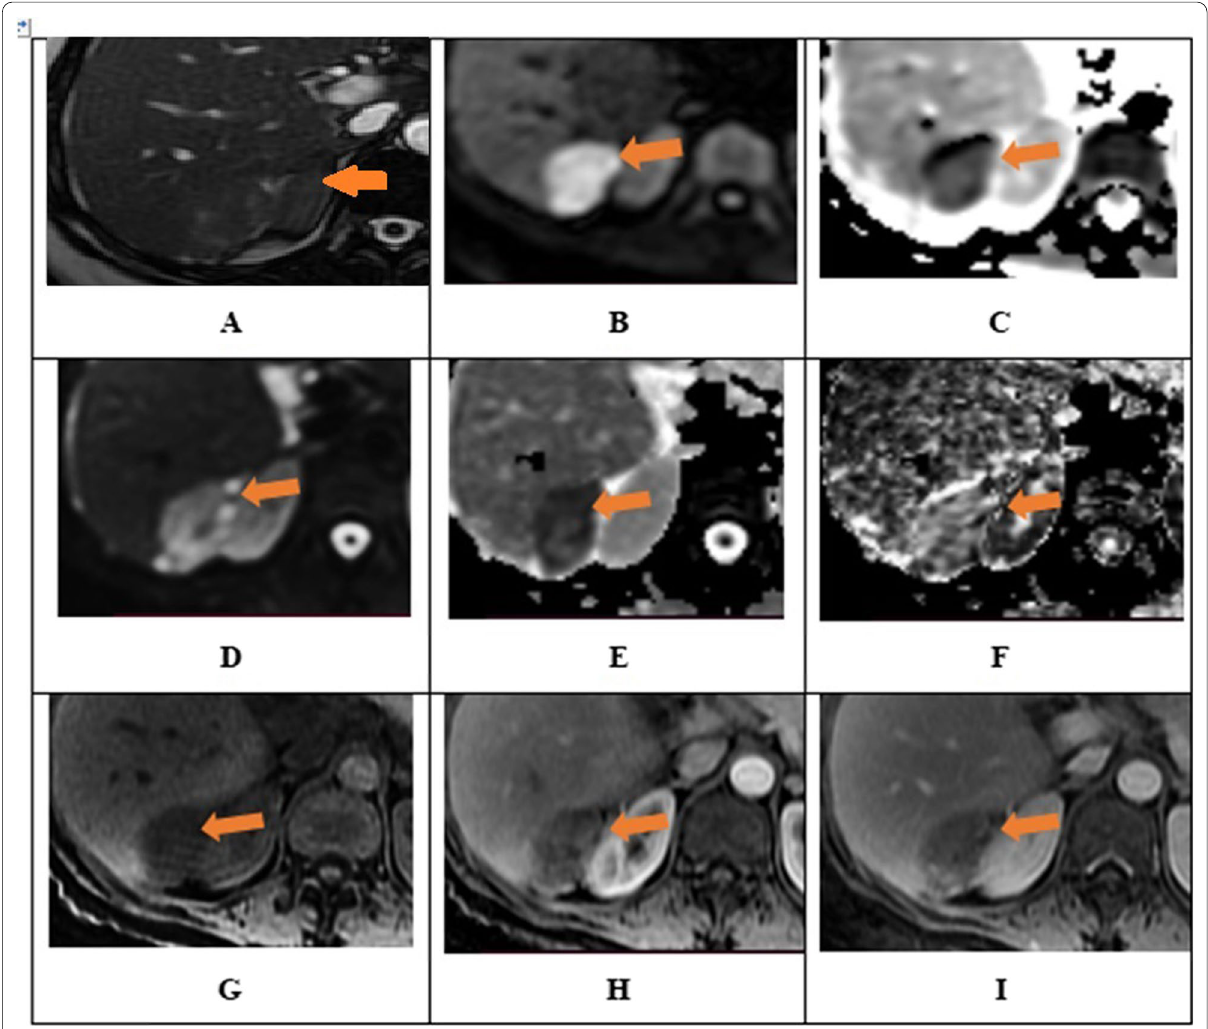
Fig. 2 A 45-year-old female patient with positive HCV and history of ovarian cancer underwent abdominal ultrasonography that showed right hepatic focal lesion. A Axial T2 image shows a 4 cm segment VI focal lesion displaying low T2 signal. B axial diffusion and C ADC images show marked diffusion restriction with DWI-ADC value 0.82 D Axial DTI gray scale image, E DTI-ADC map and F FA map: the DTI-ADC value is 0.57 and the FA value was high 0.54. G non-contrast T1 H arterial phase and I delayed phase of the dynamic study showed heterogeneous enhancement of the lesions. The lesion was categorized as LR-M. True cut biopsy was done and the pathology result was metastatic